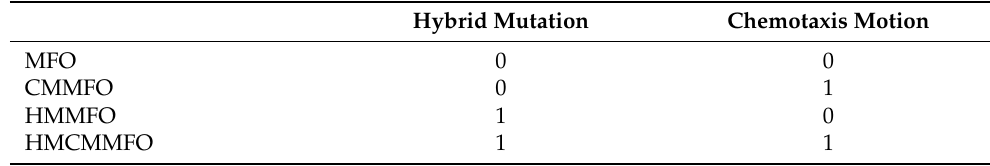
Table 4. Performance of the two strategies on MFO.